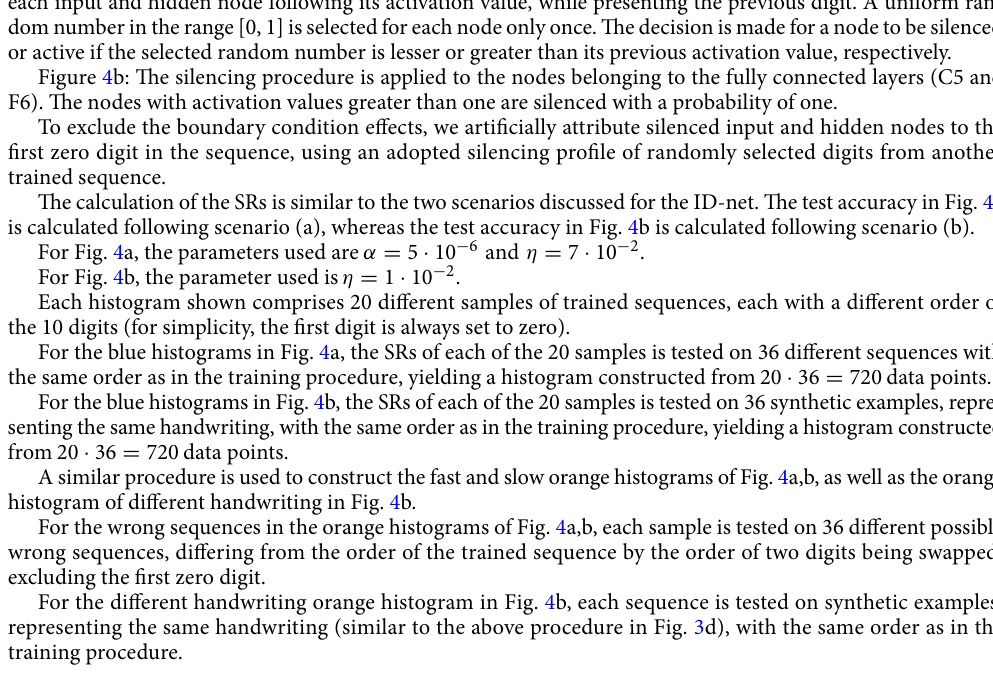
Figure 4b: ReLU activation functions are assigned to the hidden and output nodes, and the backward propa- gation comprises a gradient descent method using a cross entropy error function. The terms in the backpropagation, including silenced input nodes or silenced hidden nodes,